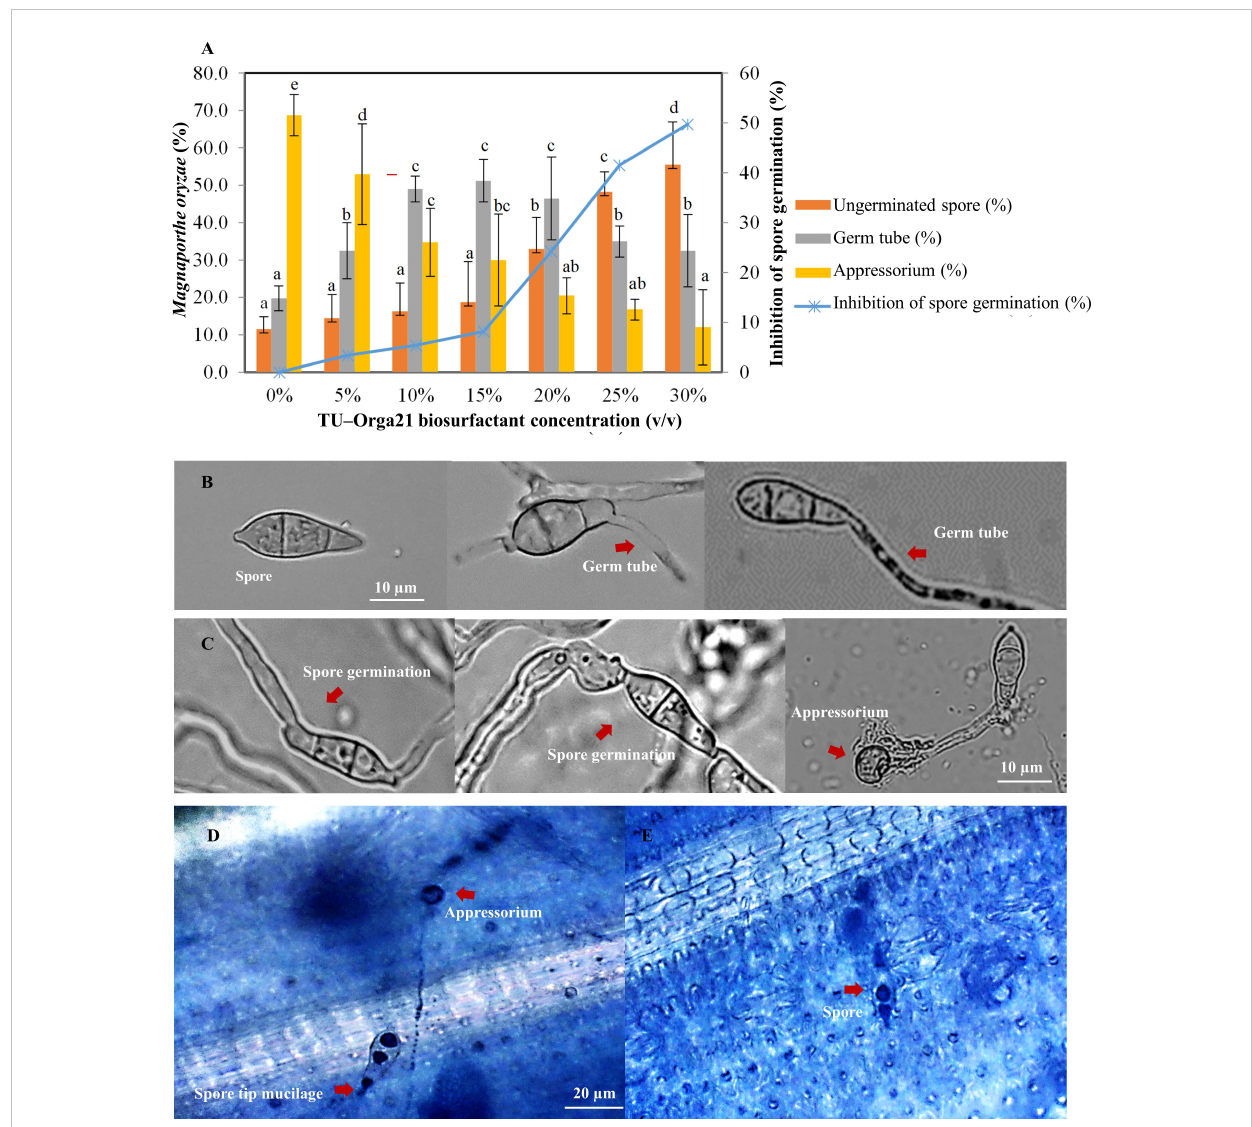
FIGURE 3 Ef fi cacy of the Bacillus vallismortis biosurfactant. (A) Percentage of spore, germ tube, and appressorium (left ordinate) and inhibition of spore germination compared with the control treatment (0%) at 16 hpi (right ordinate). (B) Spore and spore which produced germ tube on hydrophobic coverslips in B vallismortis biosurfactant-treated (C) Spore germination and appressorium formation on hydrophobic coverslips in control. (D) Spore tip mucilage and appressorium formation in control sample. (E) Spores without germination in 30% v / v of biosurfactant-treated sample. Values are presented as the mean of four replicates. Means in the graph followed by different letters is a are signi fi cantly different according to DMRT at p =